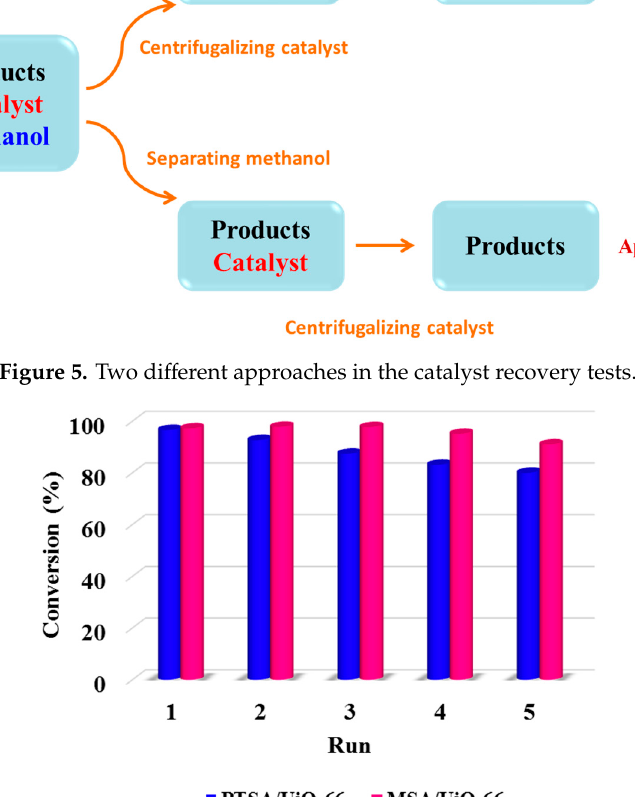
Figure 6. Reusability of solid catalysts in the esterification of PA with methanol.